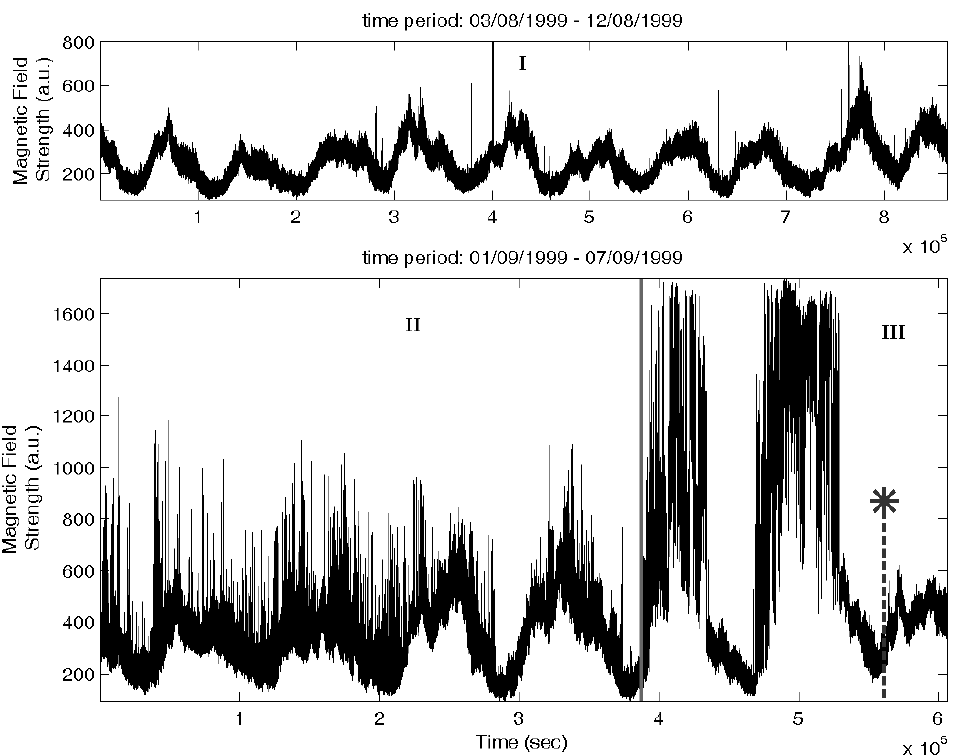
Fig. 2. Focused views of the EM recording. Three different time epochs are noted: the first (I, upper graph) covers from 3 August 1999, 00:00:00 to 12 August 1999, 23:59:59 (UT), the second (II, lower graph) from 1 September 1999, 00:00:00 to 5 September 1999, 11:51:00 (UT), and the third (III, lower graph) from 5 September 1999, 11:51:01 to 7 September 1999, 23:59:59 (UT). A vertical grey line separates epochs II and III. The star indicates the time of the Athens EQ occurrence. The horizontal axis is the time in s, denoting the relative time position from the beginning of each of the focused parts of the EM recording.